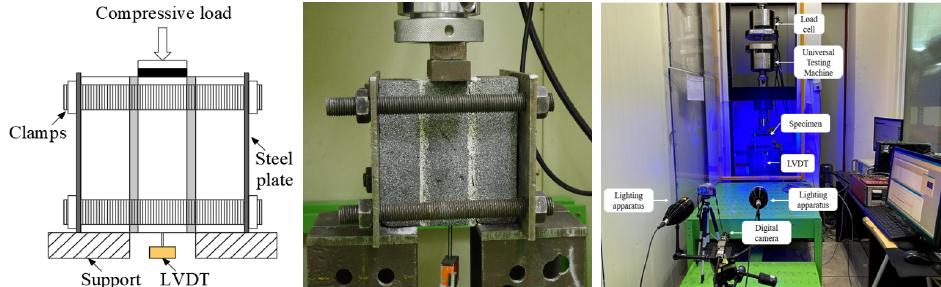
Figure 7. Experimental setups for the Triplet